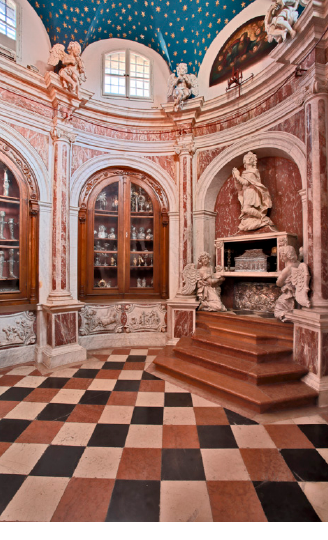
Figure 1. Saint Tryphon’s relic chapel, 1704–1708, Kotor, Saint Tryphon’s Cathedral (photo by Stevan Kordi ć ).